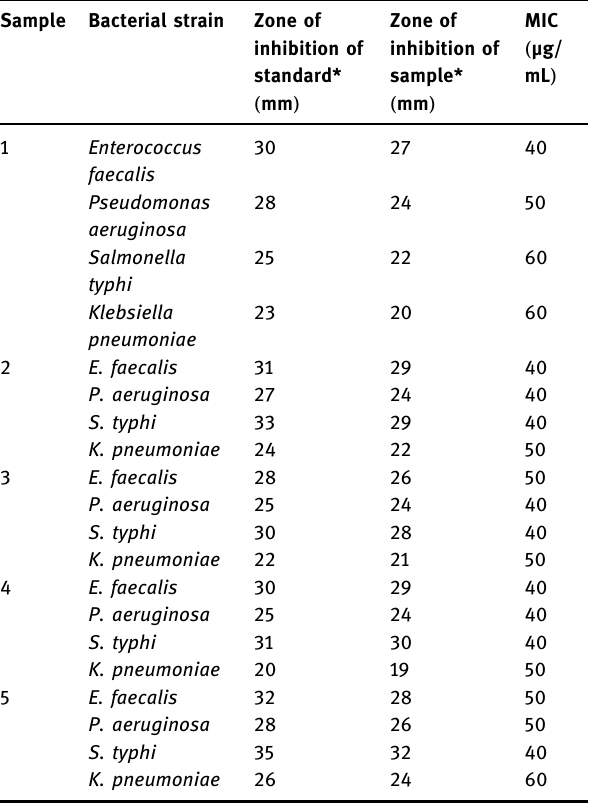
Table 1: Antibacterial spectrum of the synthesized compounds Sample Bacterial strain